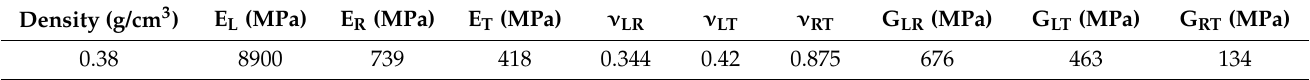
Table 1. Elastic parameters of poplar species at 12% moisture content [10].